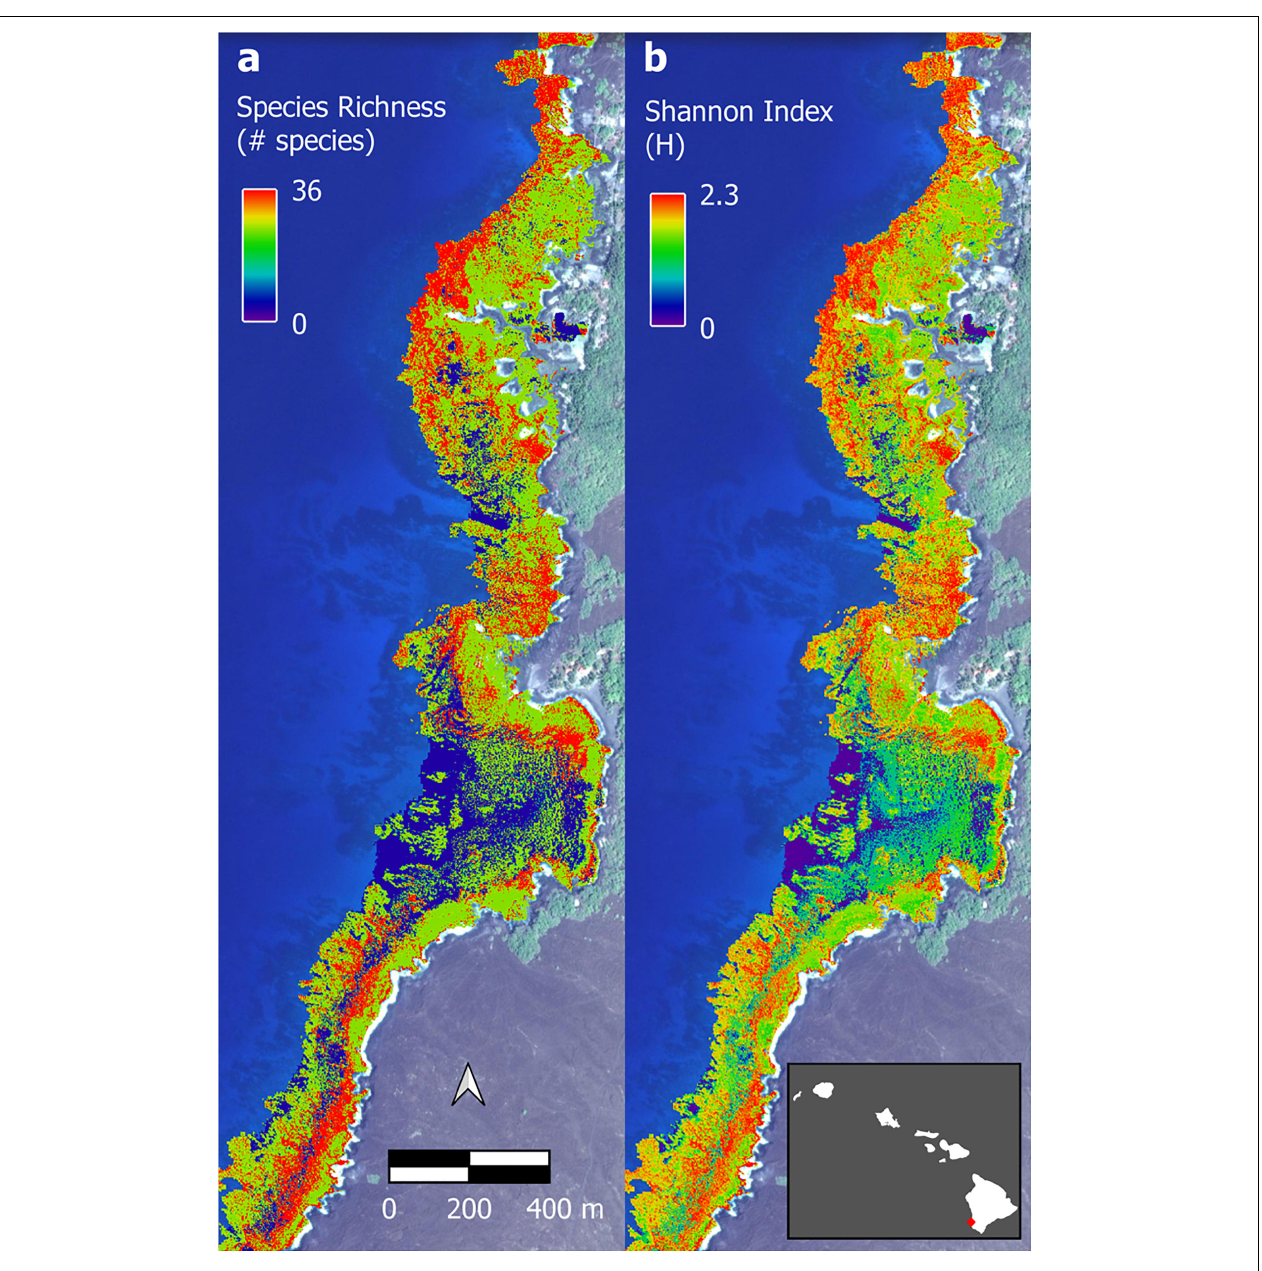
FIGURE 8 | Example of upscaled biodiversity maps of Honomalino Bay using (a) species richness and (b) Shannon diversity index. Full maps in Supplementary Figures 11, 12 . Background imagery retrieved from Google, ©2021 Maxar Technologies.